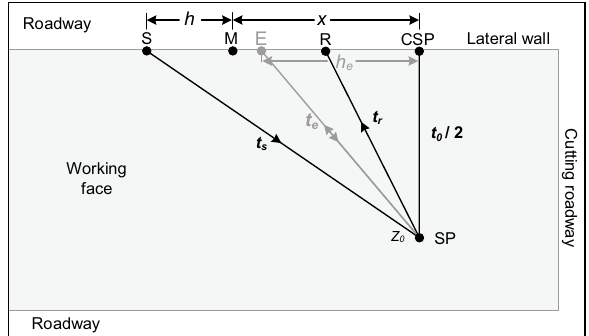
Fig. 1 Schematic of the equivalent offset definition in the mine work- ing face. CSP represents the projection of the common scattering point on the lateral wall, t 0 is the zero-offset two-way travel time of the scattering point SP, h e is the equivalent offset, E is the juxtaposed equivalent source point and equivalent receiving point, and t e is the travel time from E to the scattering